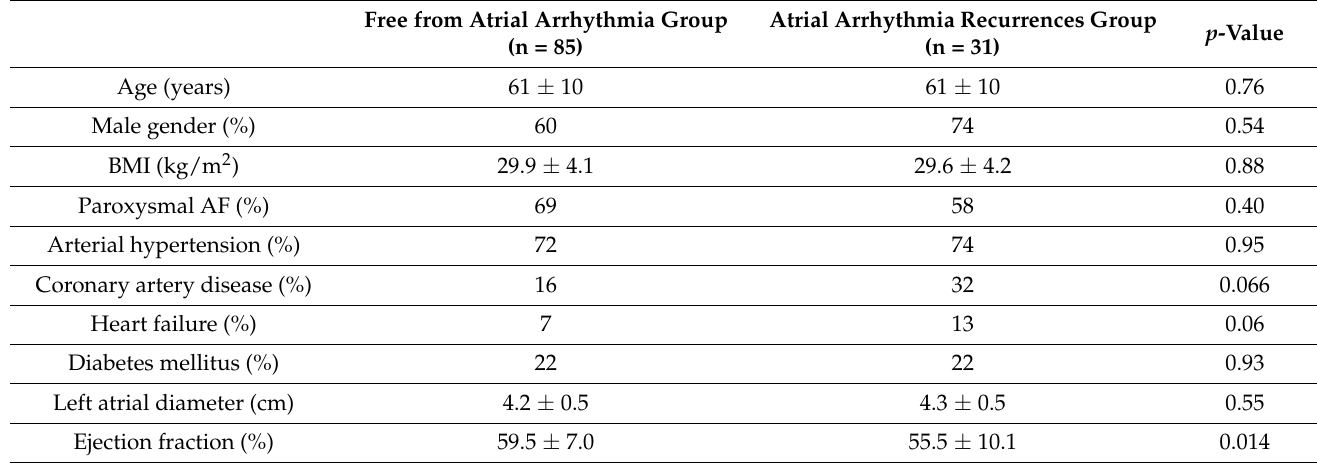
Table 4. Analysis of the impact of clinical factors on the arrhythmia recurrence